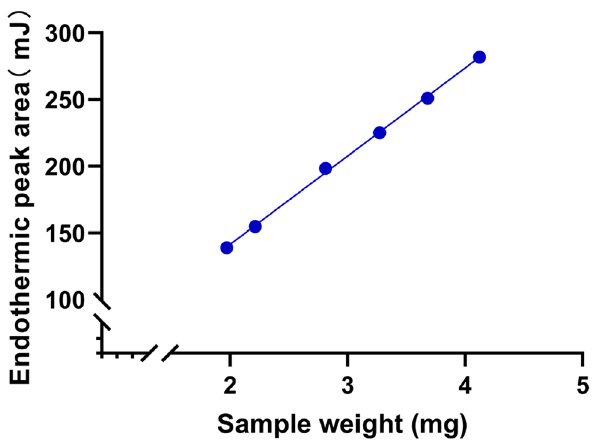
Fig. 2 Linear regression result of the investigation of sample weigh- ing of Betulin